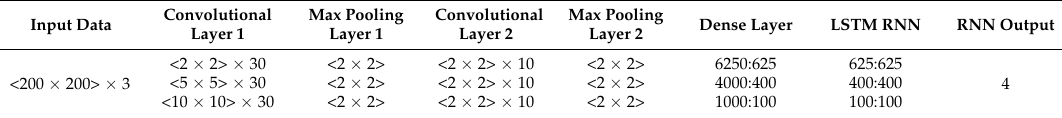
Table 4. The configurations of CNN. The parameters are denoted as <input size/receptive field size/pooling size> × <number of kernels/channels/out size>.